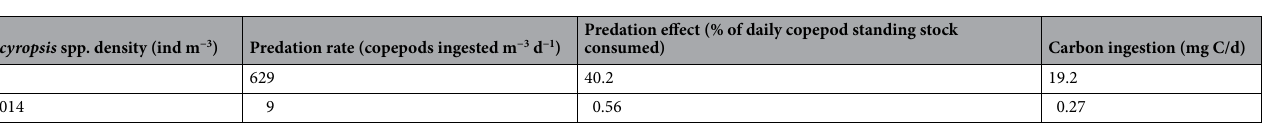
Table 3. Predation impact estimates for high and low-end Ocyropsis spp.